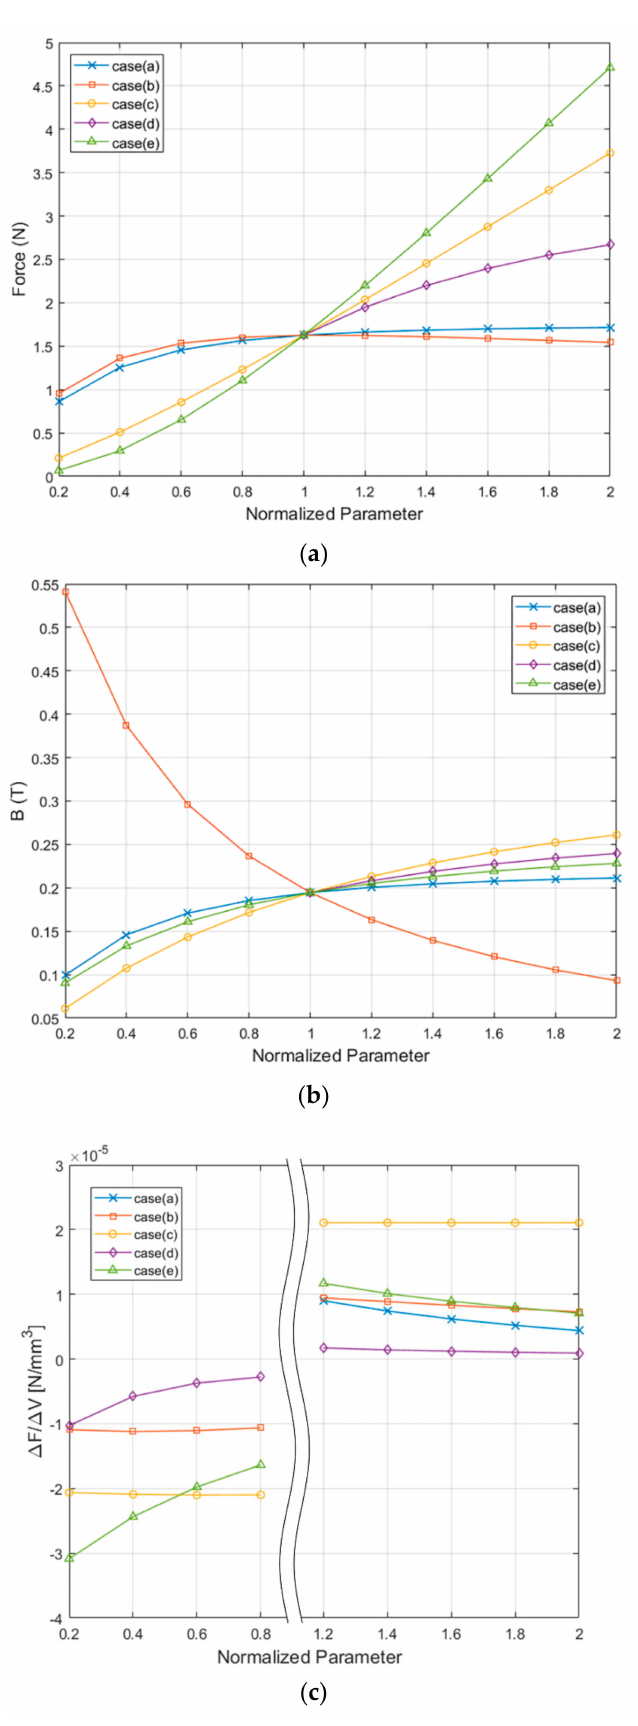
Figure 8. Results of analysis of the VVCM, ( a ) Force, ( b ) Average magnetic flux density, ( c ) force